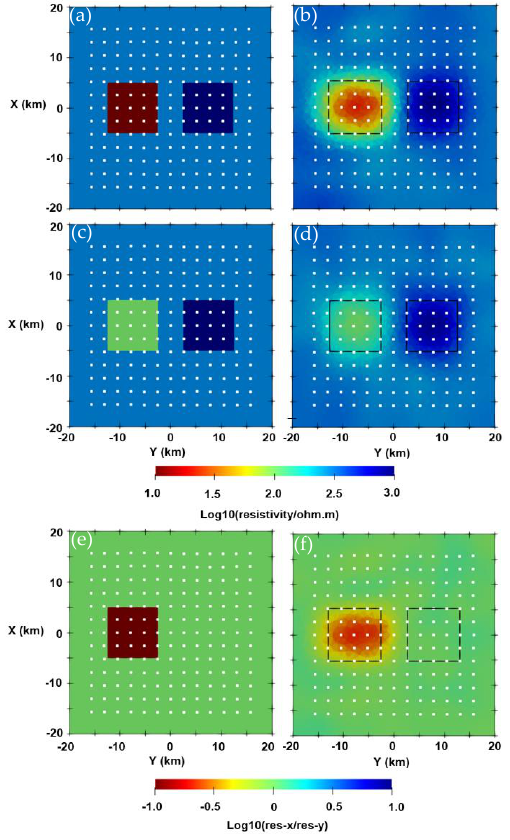
Figure 21. Anisotropic inversion results at z = 5.5 km. Panels ( a ), ( c ), and ( e ) show the true model for the principal X and Y directions, and the anisotropic coefficient. Panels ( b ), ( d ), and ( f ) show the anisotropic inversion results for the principal X and Y directions, and the anisotropic coefficient. The data fitting is shown in Figure 22, we choose the Z xy and Z yx components at the with the predicted data.